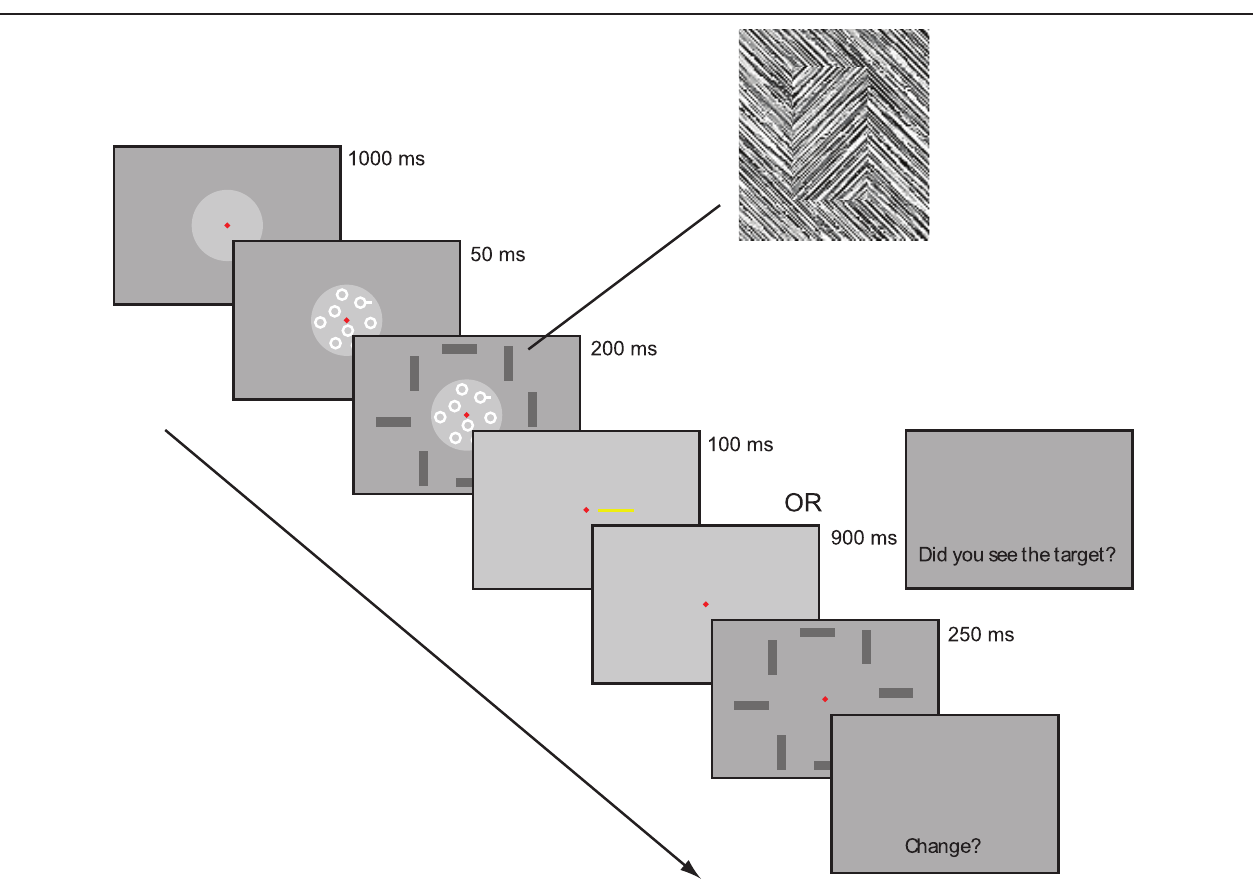
FIGURE 1 | An example of a trial sequence in Experiment 1. Here, visual search is easy and the change detection task includes a change. Rectangles in vertical or horizontal orientation were composed of texture identical to background (inset).